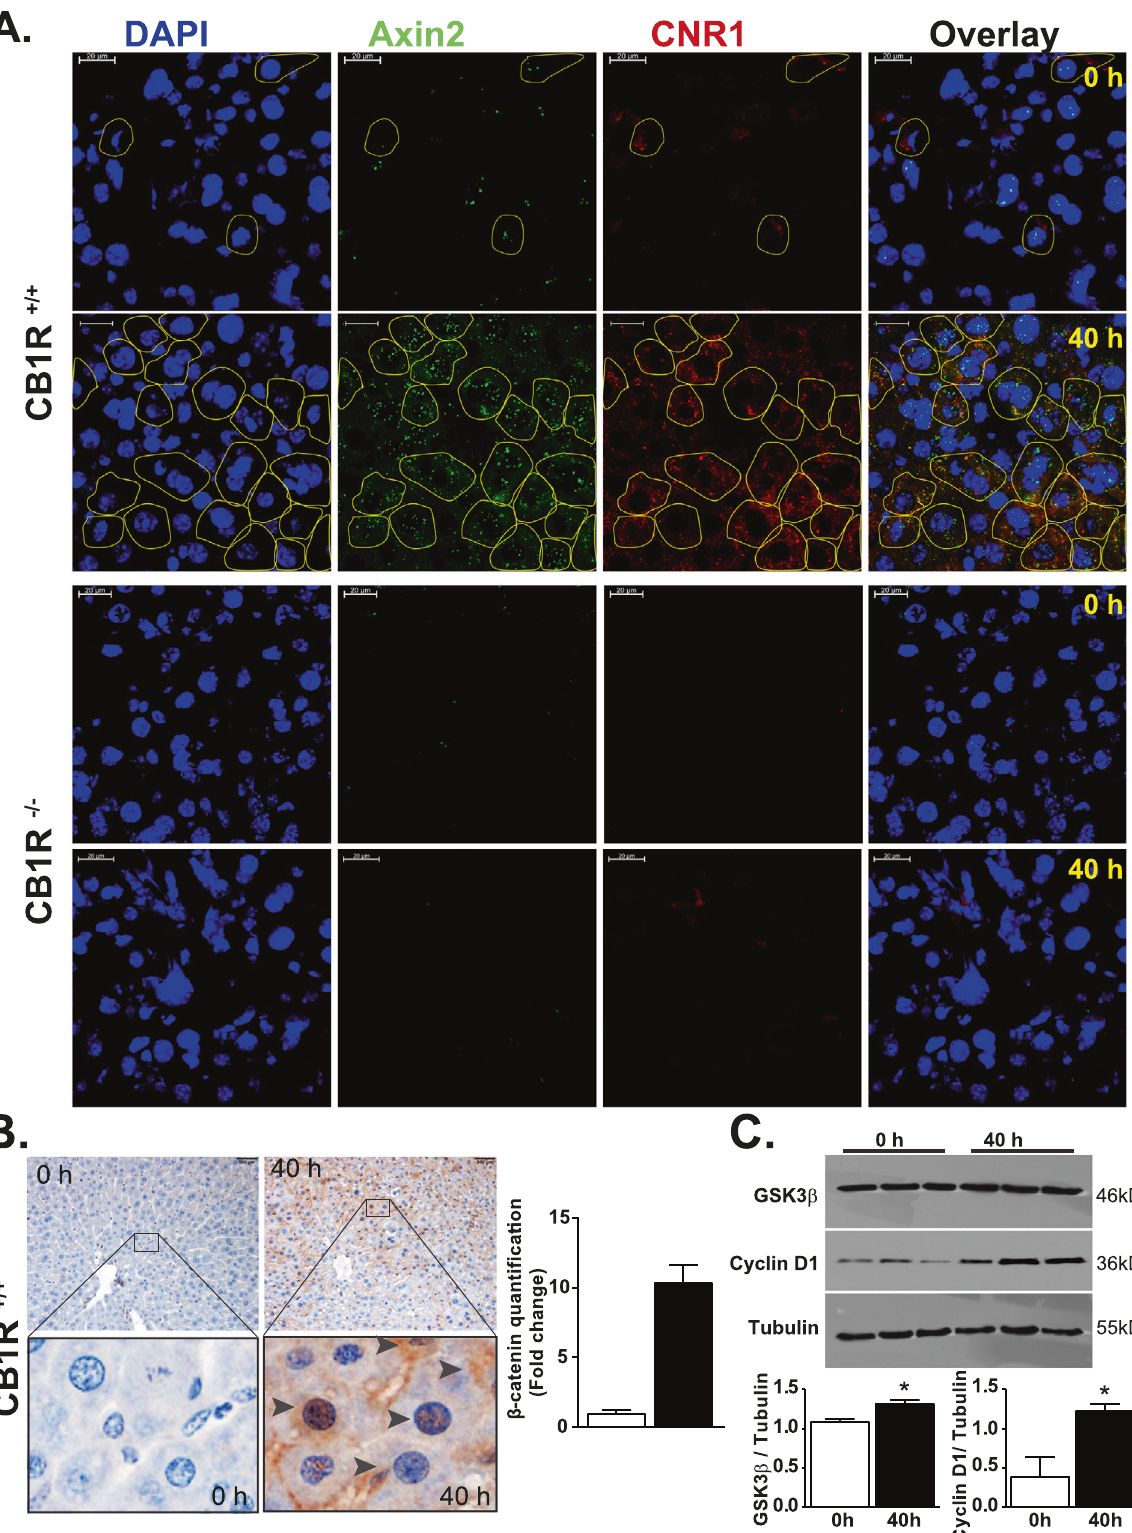
Fig. 1 Expression of Axin2 and Cnr1 in post-hepatectomy remnant liver from wild-type (CB 1 R + / + ) and CB 1 R − / − mice. A Representative RNAScope analyses of Axin2 , Cnr1 and their co-expression in wild-type (CB 1 R + / + ) and CB 1 R − / − liver samples at 0 and 40 h after PHx. B Representative immunohistochemical analyses and quanti fi cation of β -catenin protein expression in 0 h control and 40 h post-PHx liver from wild-type mice. C Representative western blot analyses and quanti fi cation by densitometry of the β -catenin target proteins GSK3 β and Cyclin D1 in 0 h control and 40 h post-PHx liver